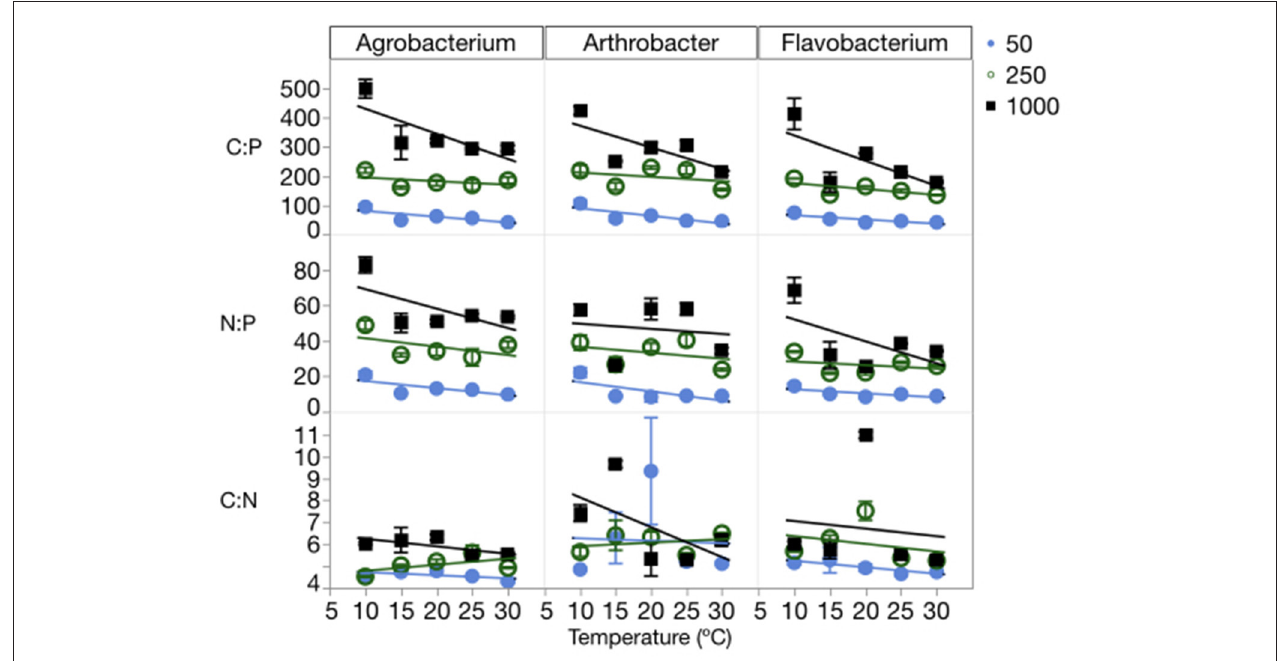
FIGURE 4 | Changes in the biomass stoichiometry (molar ratios of C:P, C:N, and N:P) of each strain across temperatures, with different symbols for each level of supply C:P. Error bars represent one standard error of the mean. The three-way ANOVA for C:N showed significant effects of strain and supply C:P only ( p < 0.001). The ANOVA for C:P showed significant effects of strain, temperature, supply C:P, an interaction between strain and supply C:P, and an interaction between temperature and supply C:P ( p < 0.01). The ANOVA for N:P showed significant effects of strain, temperature, supply C:P, and an interaction between strain and supply C:P ( p <